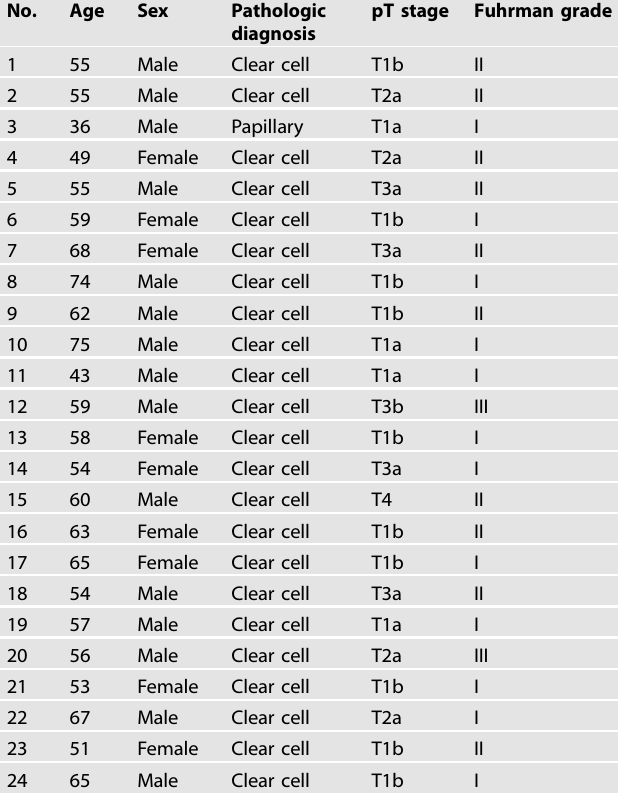
Table 1. Clinical data of the RCC patients ( n =